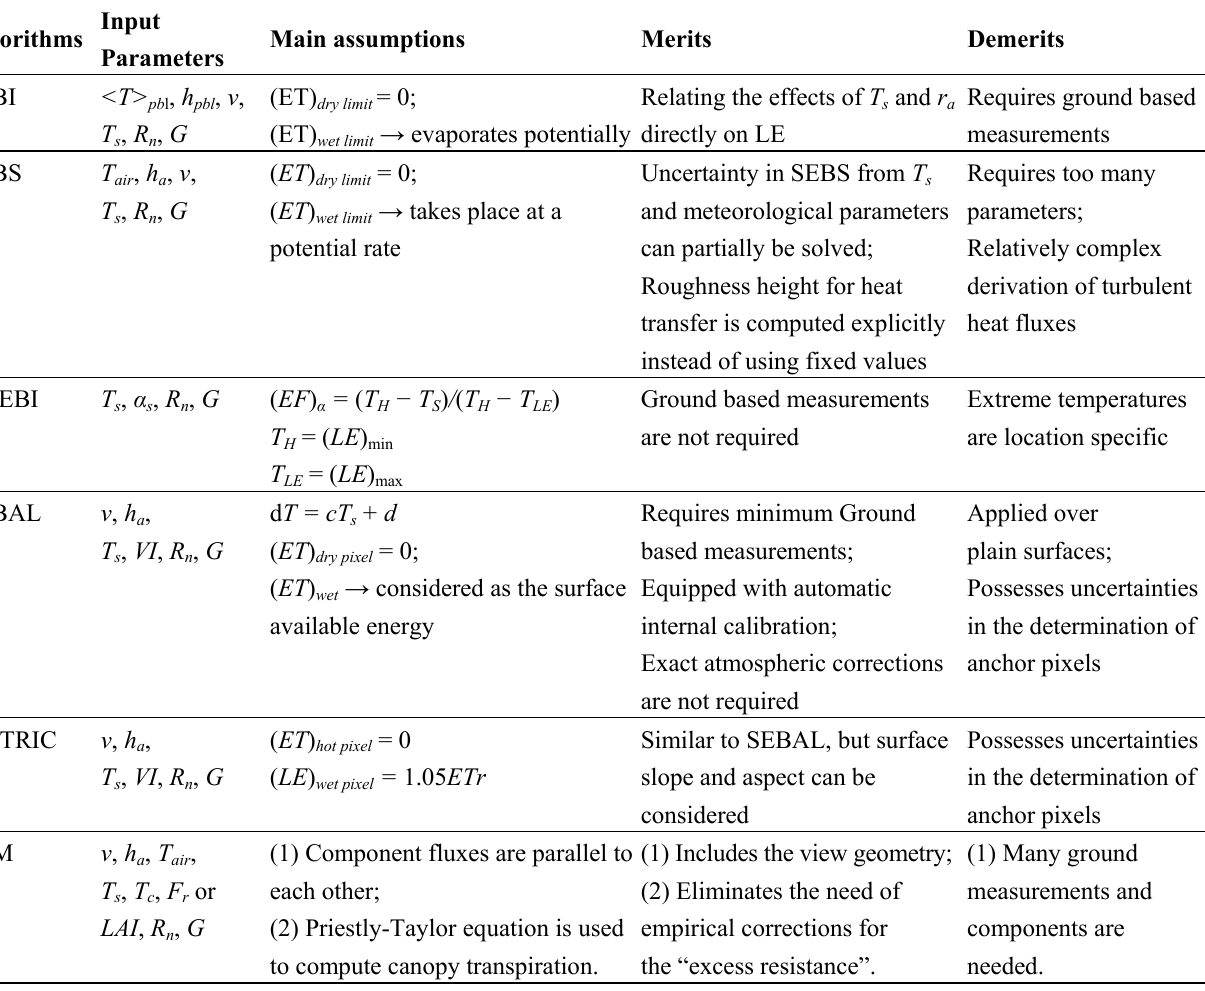
Table 1. Comparisons of the different remote sensing ET